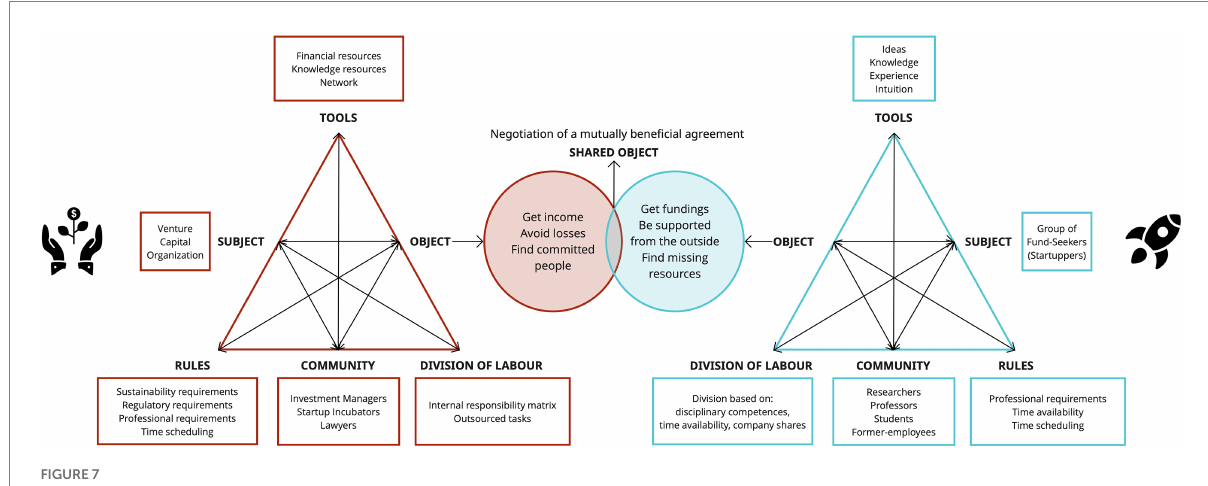
FIGURE 7 III generation of AT framed in a IHC